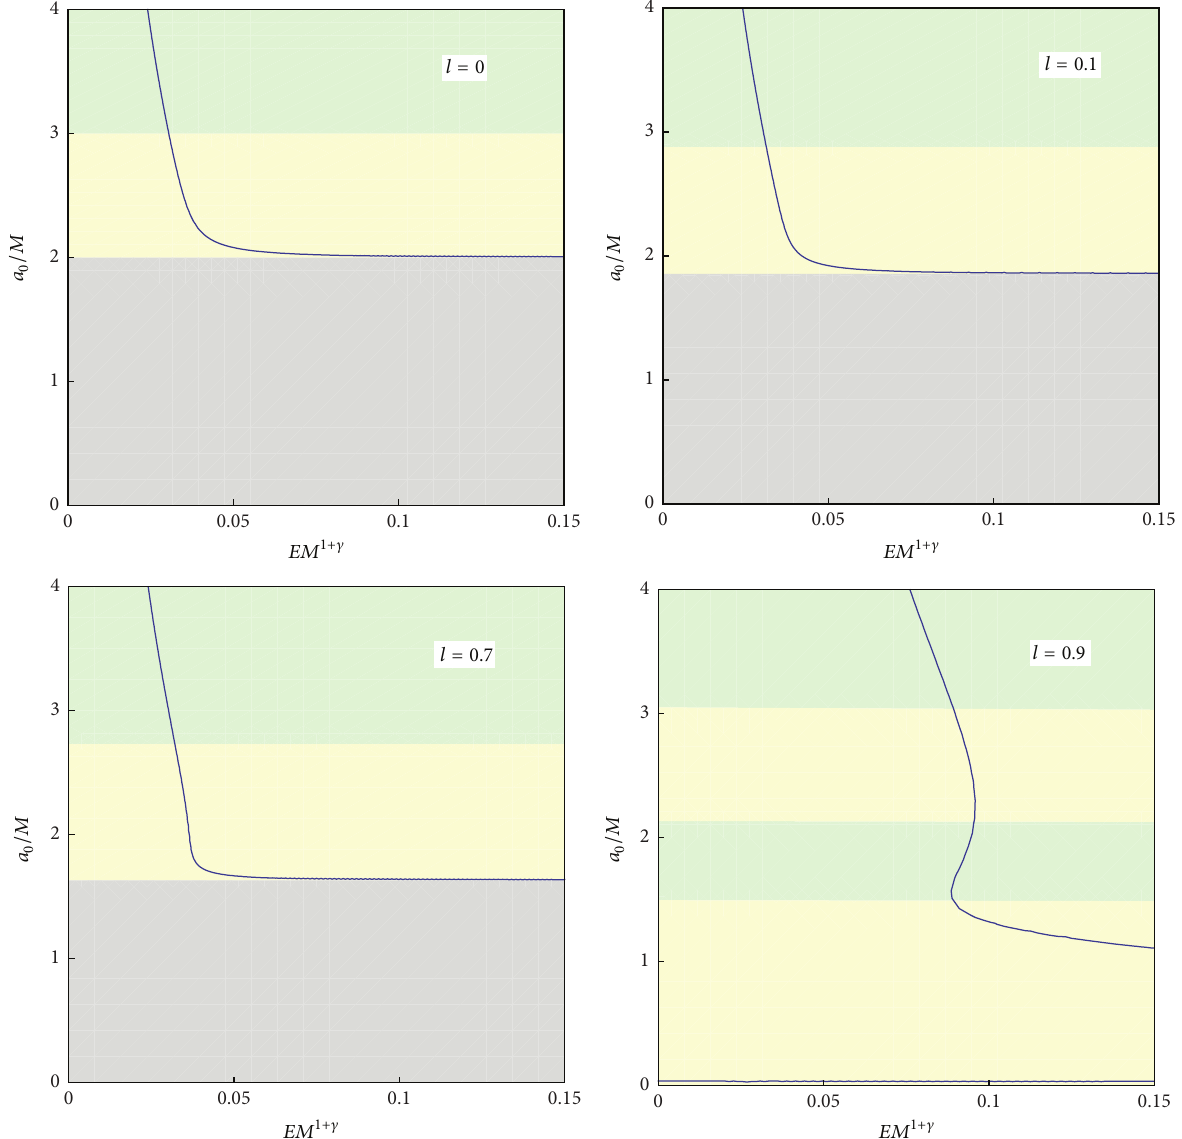
Figure 7: Plots for MCCG with 𝛾 = 0.2 , 𝑀 = 1 , 𝐴 = 1 , and 𝑤 = −10 with different values of 𝑙 . Here, 𝐸𝑀 (1+𝛾) and 𝑎 0 /𝑀 are labeled along abscissa and ordinate,